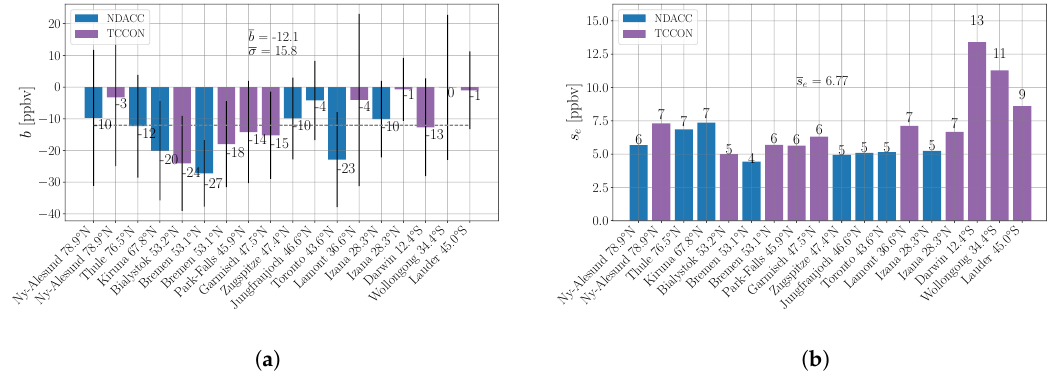
Figure 7. Mean bias of NDACC (blue) and TCCON (purple) stations with co-located SCIAMACHY CO retrievals from 2003 to 2011. Bias is the average of the monthly-mean differences weighted by the standard deviations. The total (2003–2011) bias per site was subsequently calculated using the annual weighted biases. ( a ) Global bias b and respective global standard error σ . The dashed gray line indicates b ; ( b ) The standard error of the means s e